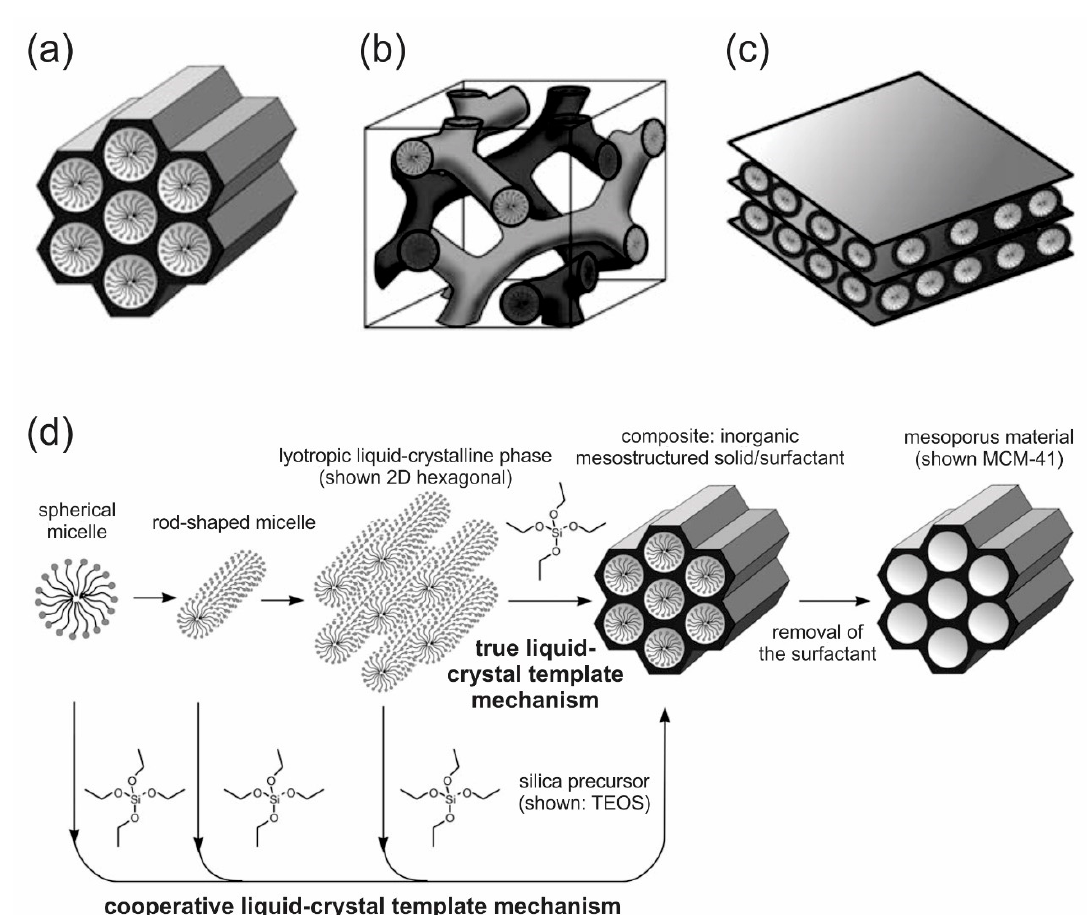
Figure 2. The different structures of mesoporous M41S materials: ( a ) mobile composition of matter (MCM)-41, ( b ) MCM-48, ( c ) MCM-50, and ( d ) the formation mechanism of mesoporous materials using structure-directing agents. Reproduced with permission from [38] .